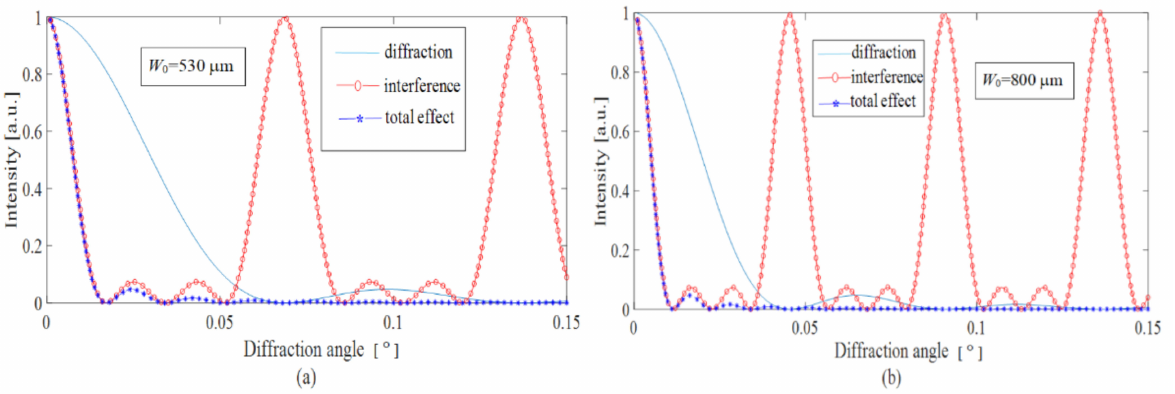
Figure 5. Diffraction, interference, and total effect for the microprism with 4.0 ∆ and with W 0 = 530 µ m for ( a ) and W 0 = 800 µ m for ( b